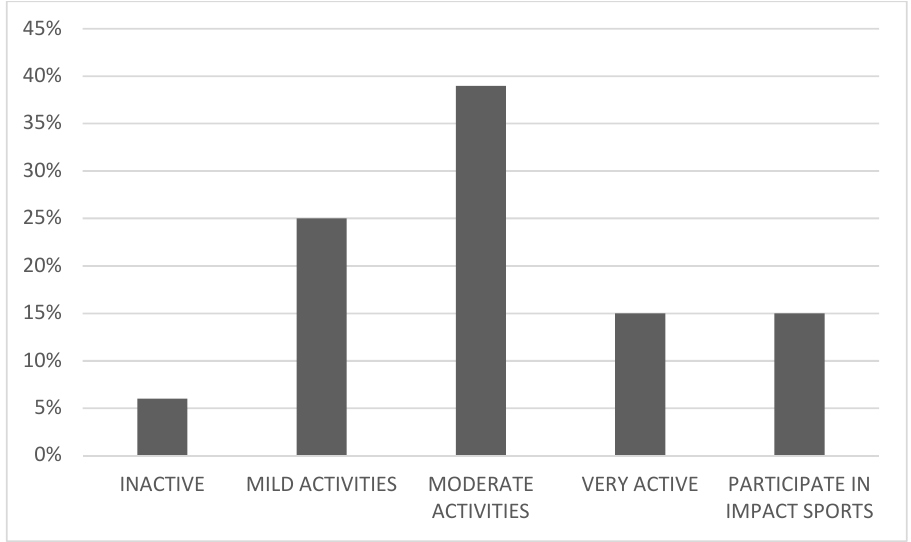
Figure 4. UCLA Activity Score results. Outcomes were grouped in: 0–2: inactive; 3–4: mild activities; 5–6: moderate activities; 7–8: very active; 9–10: participate in impact